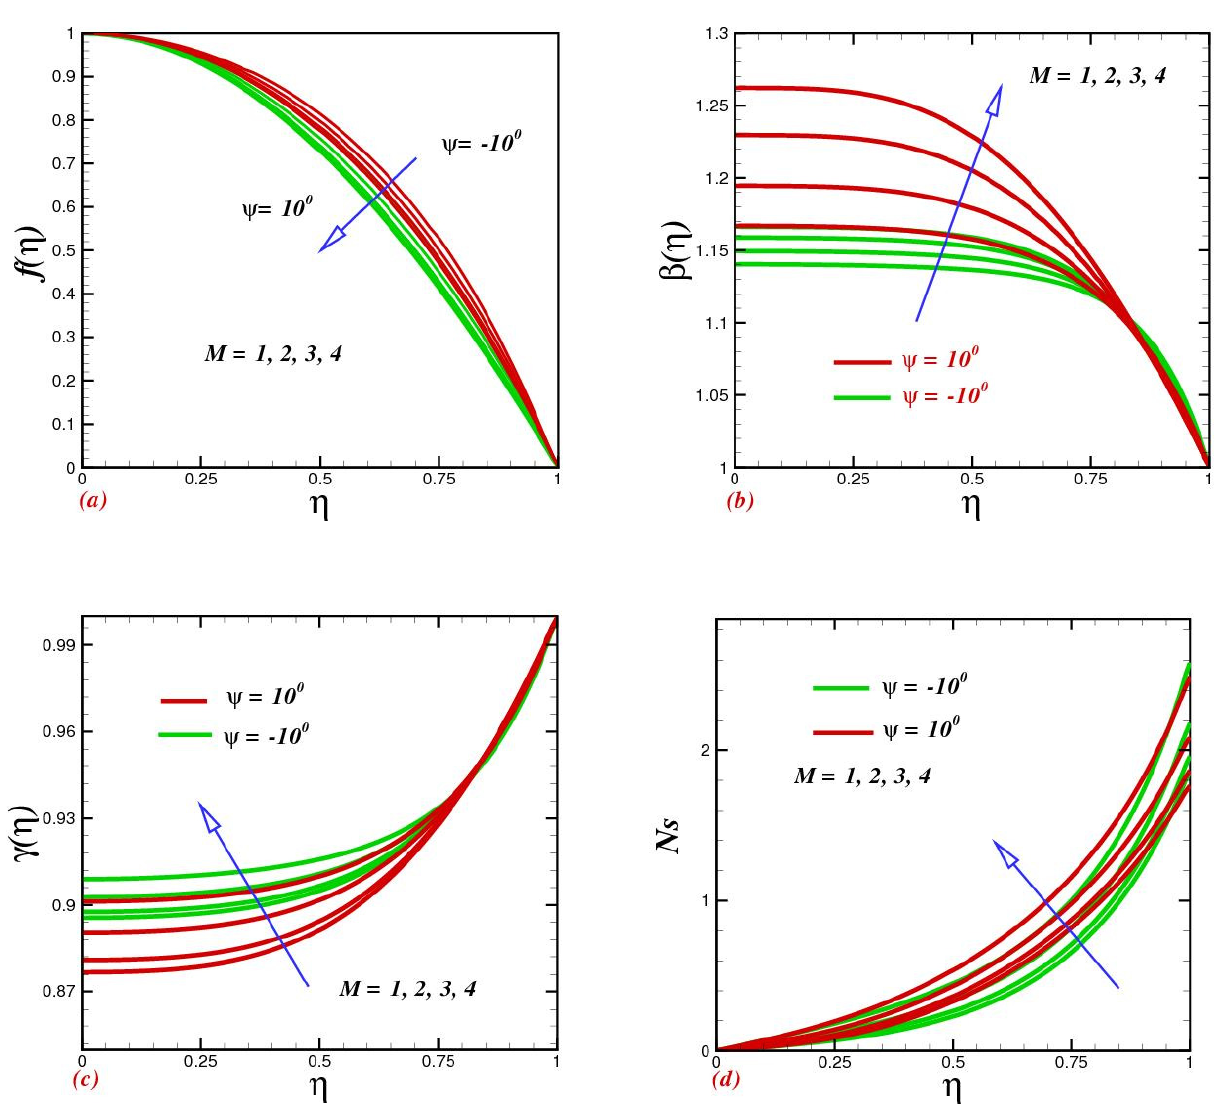
Figure 5. Impact of magnetic parameter 𝑀 on ( a ) velocity 𝑓(𝜂) , ( b ) temperature 𝛽(𝜂) , ( c ) concentration 𝛾(𝜂) , and ( d ) entropy production 𝑁𝑠 .